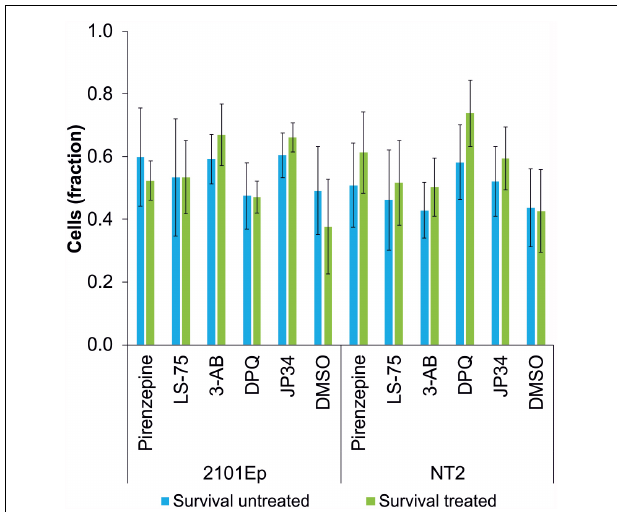
FIGURE 3 | Survival rate of cisplatin-treated tumor cell lines (2102Ep and NT2 germ cell tumor lines) without (blue bars) and with treatment (green bars) of PARP inhibitors (Pirenzipine, LS-75: 10 µ M; 3-AB: 100 µ M; DPQ, PJ34: 1 µ M; DMSO: 0.1%). No statistically significant difference in survival rate was observed. Data are expressed as the mean ( n =